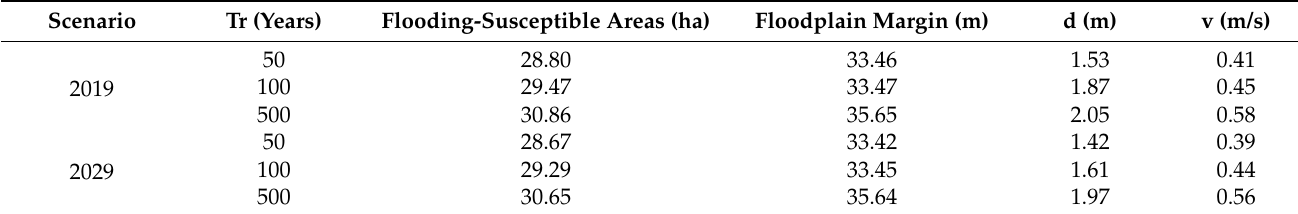
Table 4. Average distance from the center of the channel to floodplain margins along the channel, flooding-susceptible areas, and hydraulic results for each scenario.